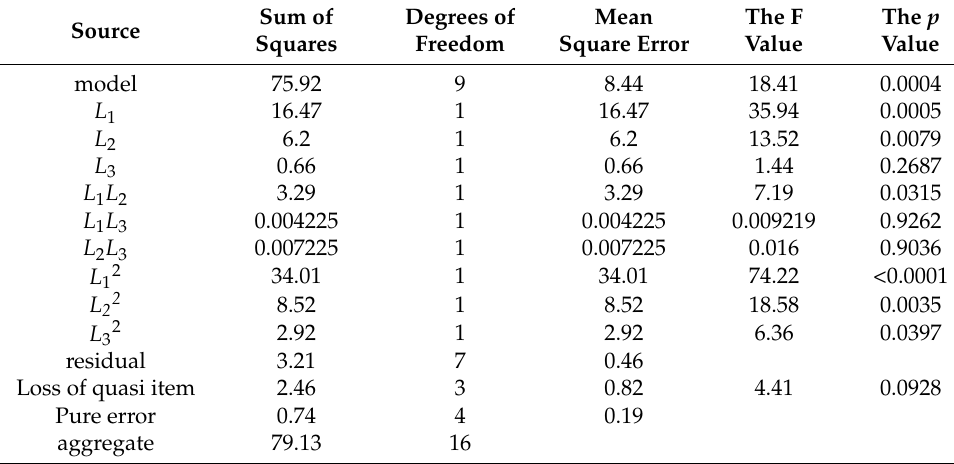
Table 4. Variance of regression